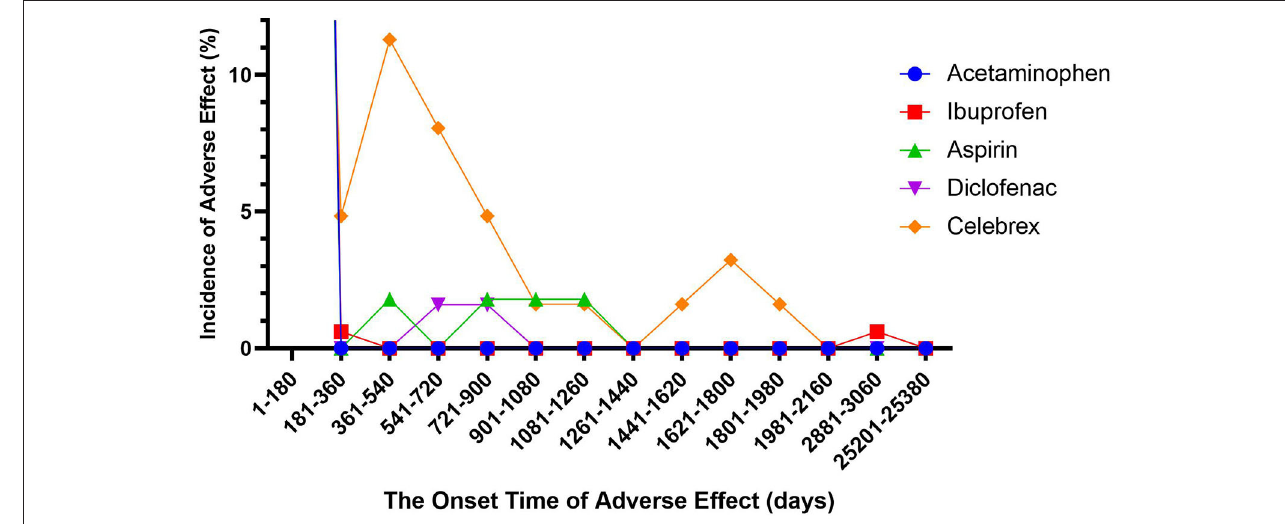
FIGURE 1 | Time to event onset of Stevens-Johnson syndrome following different non-steroidal anti-inflammatory drugs.